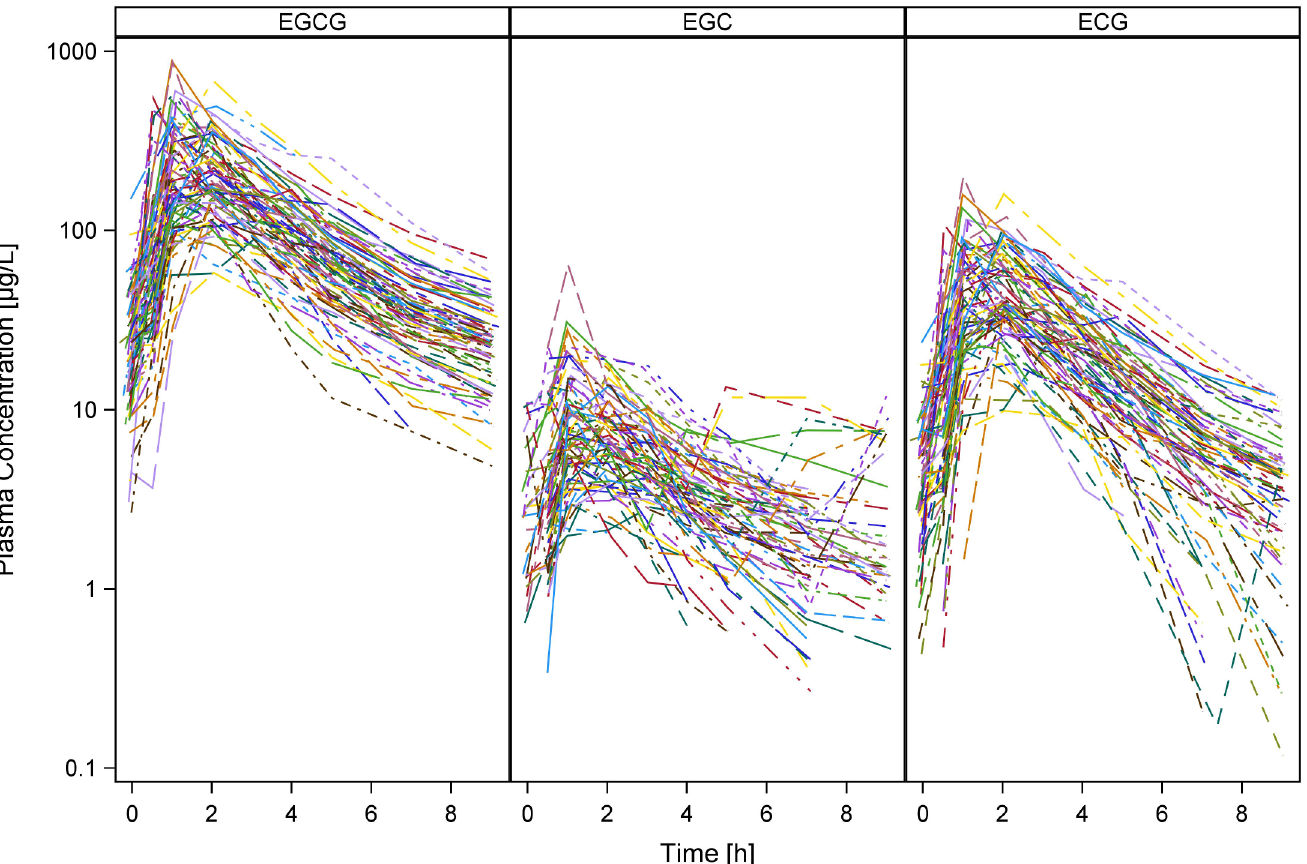
Fig 3. Individual measured plasma concentration-time profiles of EGCG, EGC and ECG on the 5 th day of oral administration.